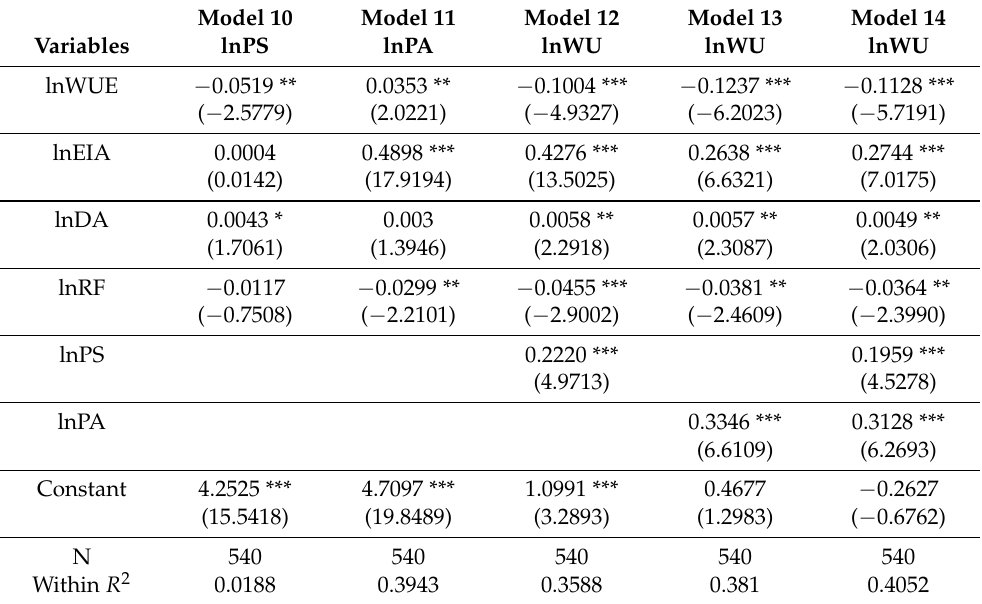
Table 5. The mechanism